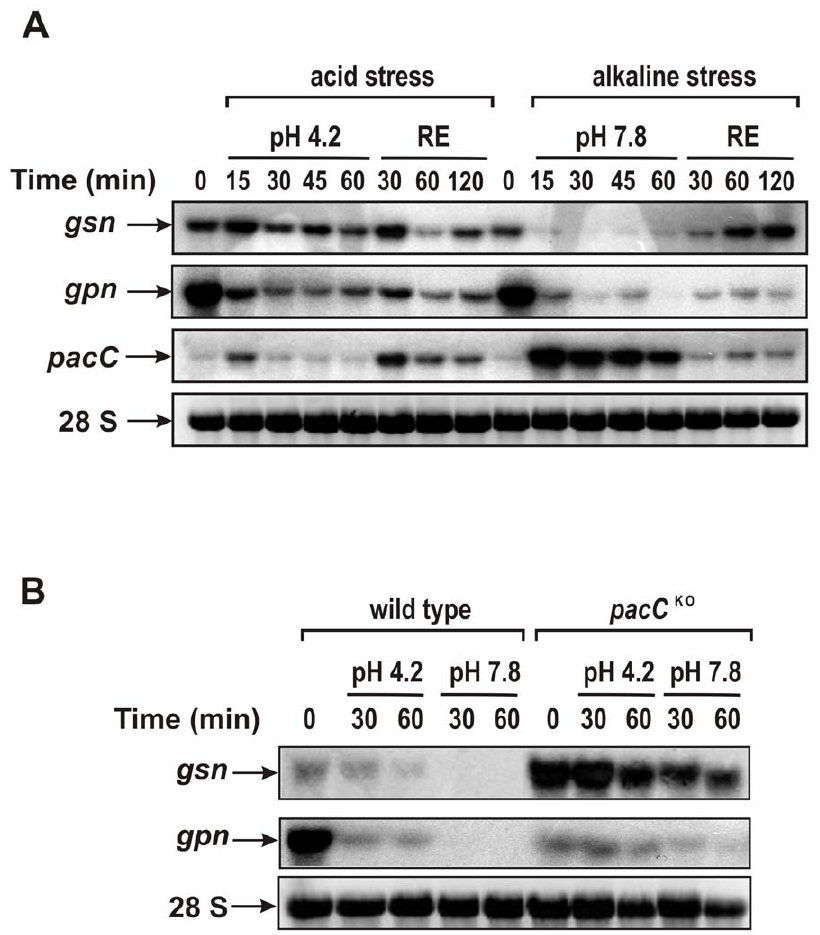
Figure 4. gsn,gpn and pacC gene expression during acid and alkaline pH stress. Cells from the wild-type and pacC KO strains were cultivated at pH 5.8 for 24 h and shifted to pH 4.2 and pH 7.8. Samples were collected and used to extract total RNA. Total RNA (15 m g) was separated by electrophoresis in a denaturing formaldehyde gel, transferred to nylon membrane and probed with a - 32 P-radiolabeled 678 bp gsn cDNA, or 798 bp gpn cDNA or 639 bp pacC cDNA fragments (gel autoradiographies). The 28 S rRNA was used as a loading control after ethidium bromide staining. The results shown are the average of at least three independent experiments. (A) Analysis of the gsn, gpn and pacC genes in the wild-type strain at different times after pH shifting. After pH stress the remaining cultures were transferred back to physiological conditions (RE, recuperation, pH 5.8) and samples were collected. (B) Analysis of the gsn and gpn genes in the pacC KO strain compared to the wild-type strain at different times after pH shifting. 0, cell samples before pH shifting